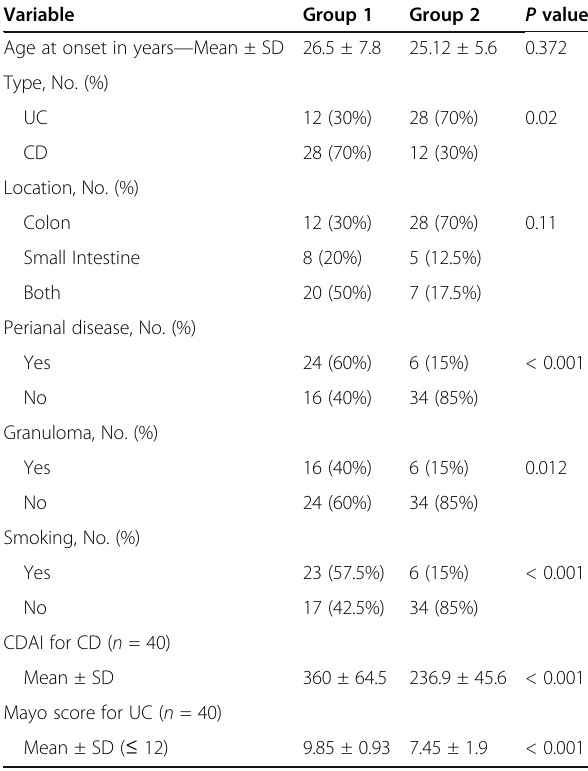
Table 1 Comparison between both groups as regard smoking and disease characteristics Variable Group 1 Group 2 P value Age at onset in years — Mean ± SD 26.5 ±